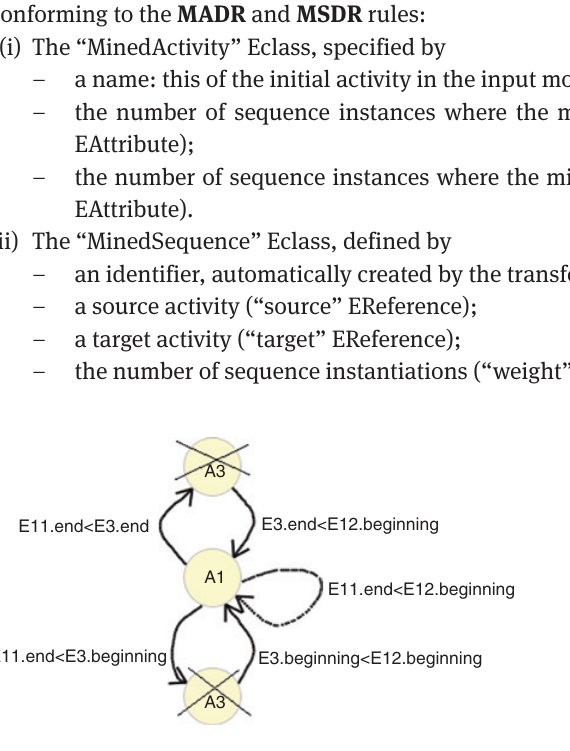
Figure 5: MSDR-LP Rule Represented by a